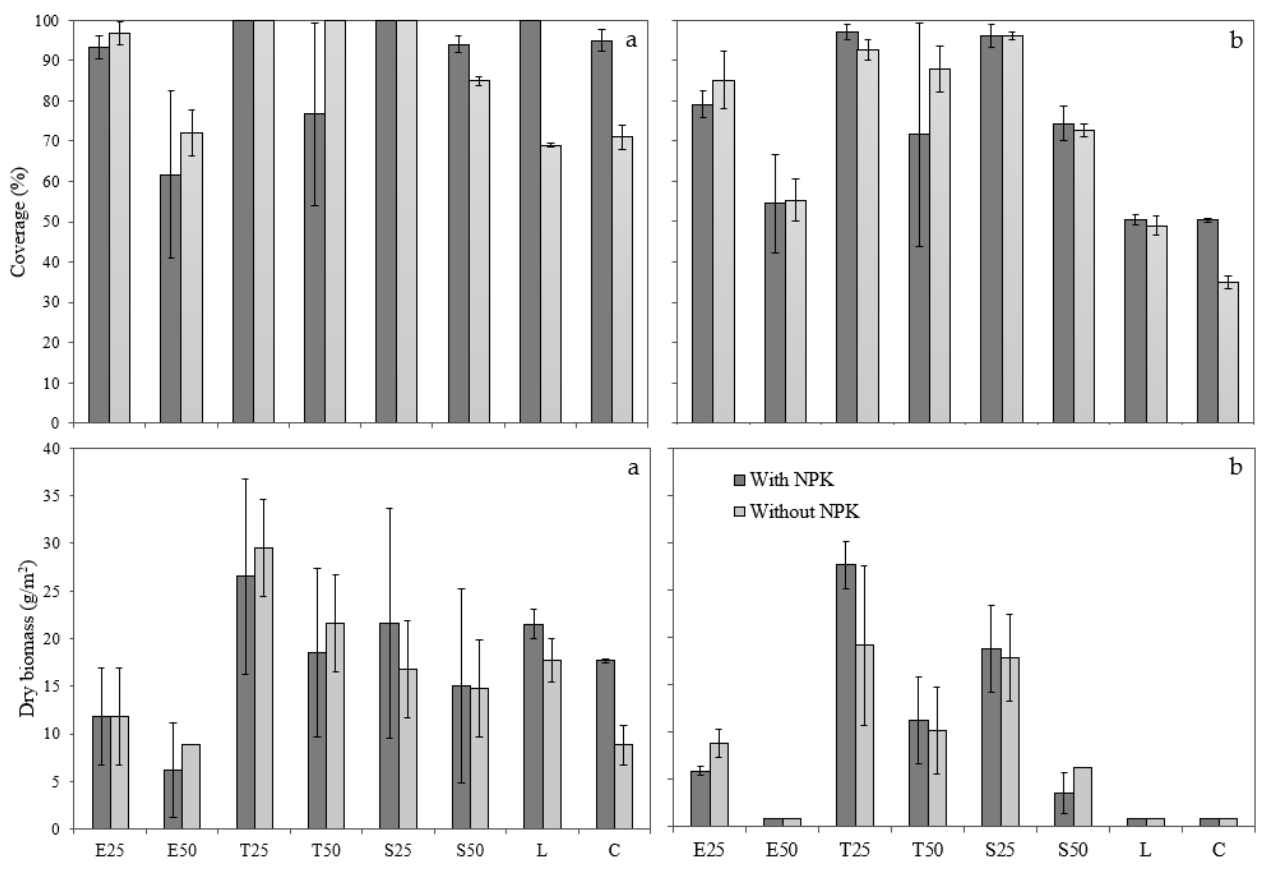
Figure 6. Coverage rate (%) and dry biomass (g m − 2 ): ( a ) first cut after 5 weeks; ( b ) second cut after 10 weeks.